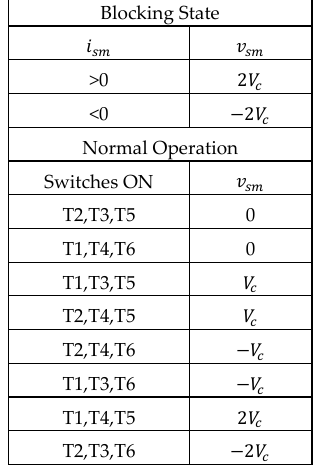
Figure 15. FLCCSM